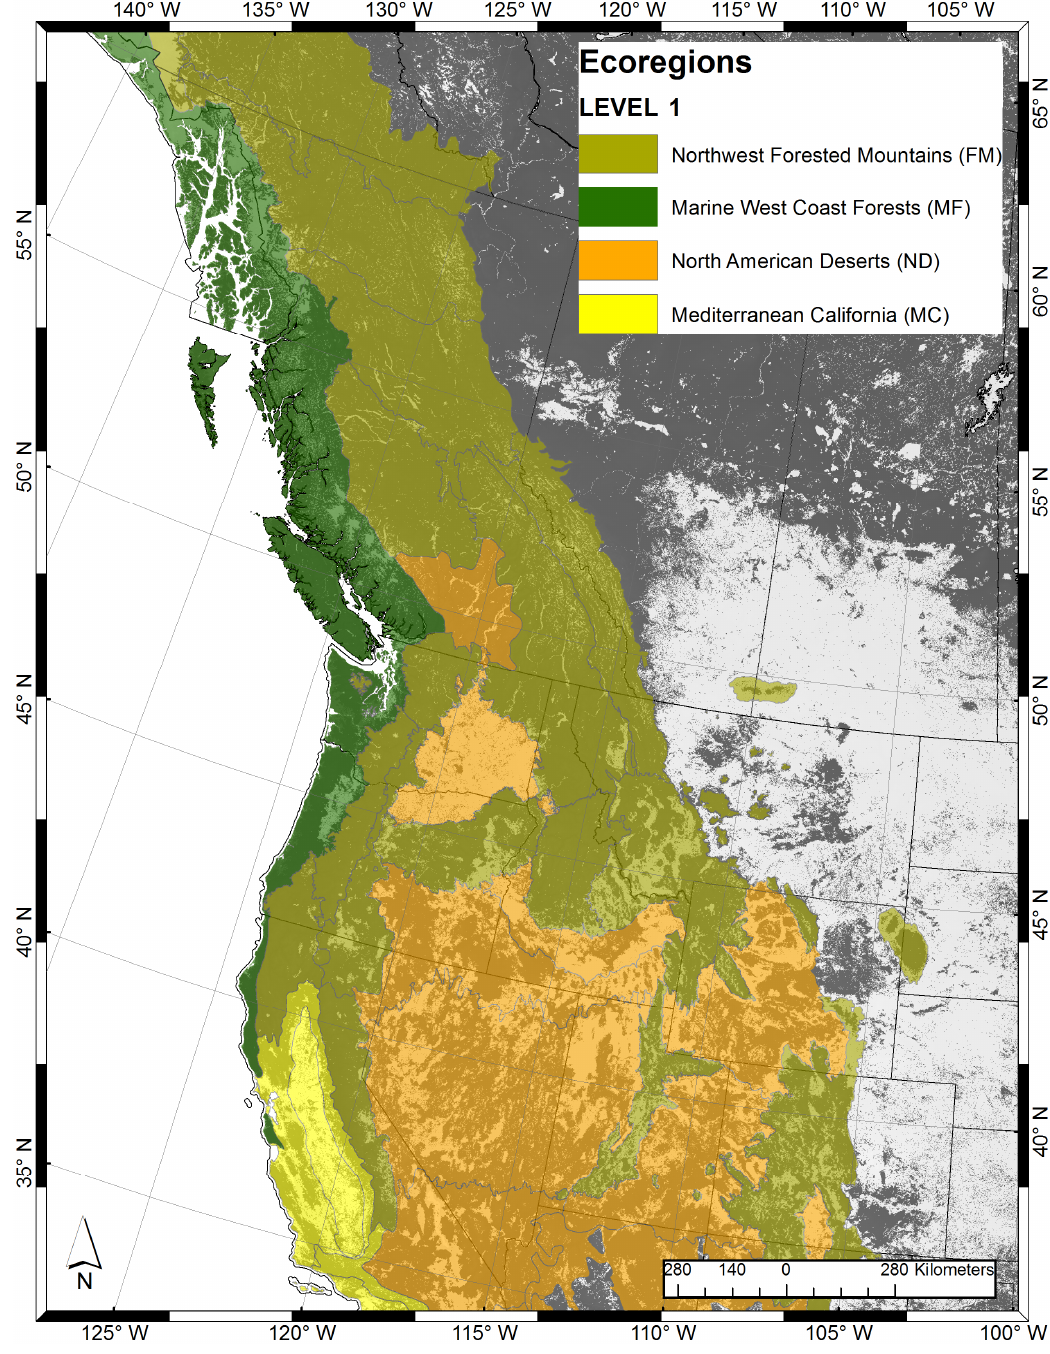
Figure 1. The maritime influence coniferous forests ecoregion (green) is among the most productive in North America. The Northwest Forested Mountain Ecoregion contains a much broader mix of species on less productive sites (olive), whereas the North American Desert Ecoregion includes drought-adapted species, such as ponderosa pine and western juniper.